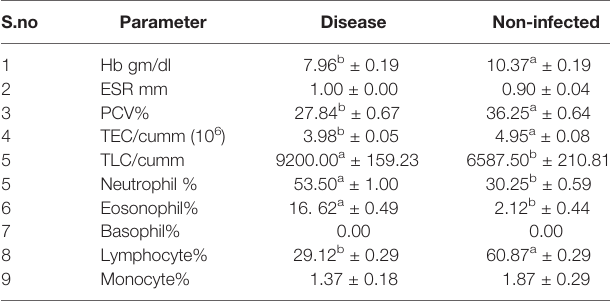
The Mean values that have superscript, was showingsigni fi cant difference between groups. The superscript ‘ a ’ was showing high mean value than ‘ b ’ . Signi fi cant at (p ≤ 0.05).